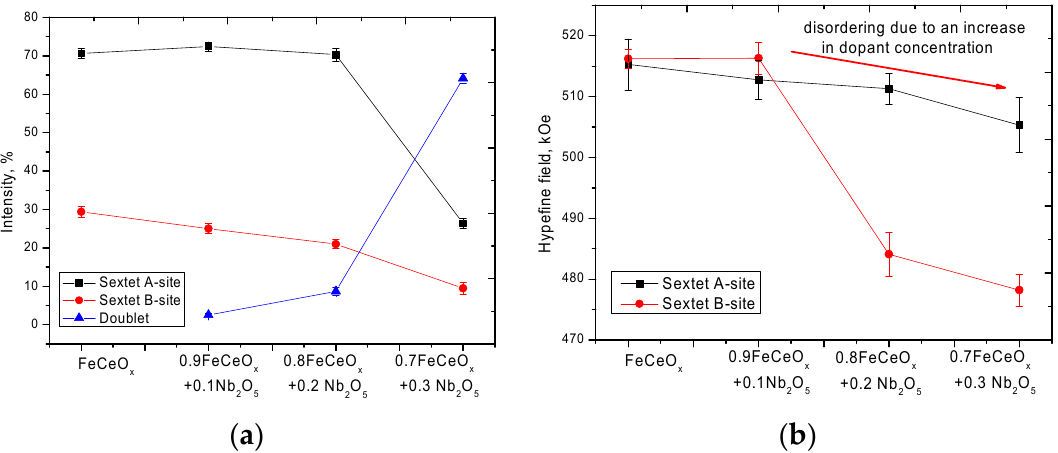
Figure 9. Changes in the hyperfine parameters of magnetic characteristics obtained on the basis of the analysis of Mössbauer data: ( a ) data of changes of contribution intensities of partial spectra depending on concentration of dopant Nb 2 O 5 ; ( b ) data on changes in the magnitude of hyperfine magnetic fields in the A- and B- sublattices.